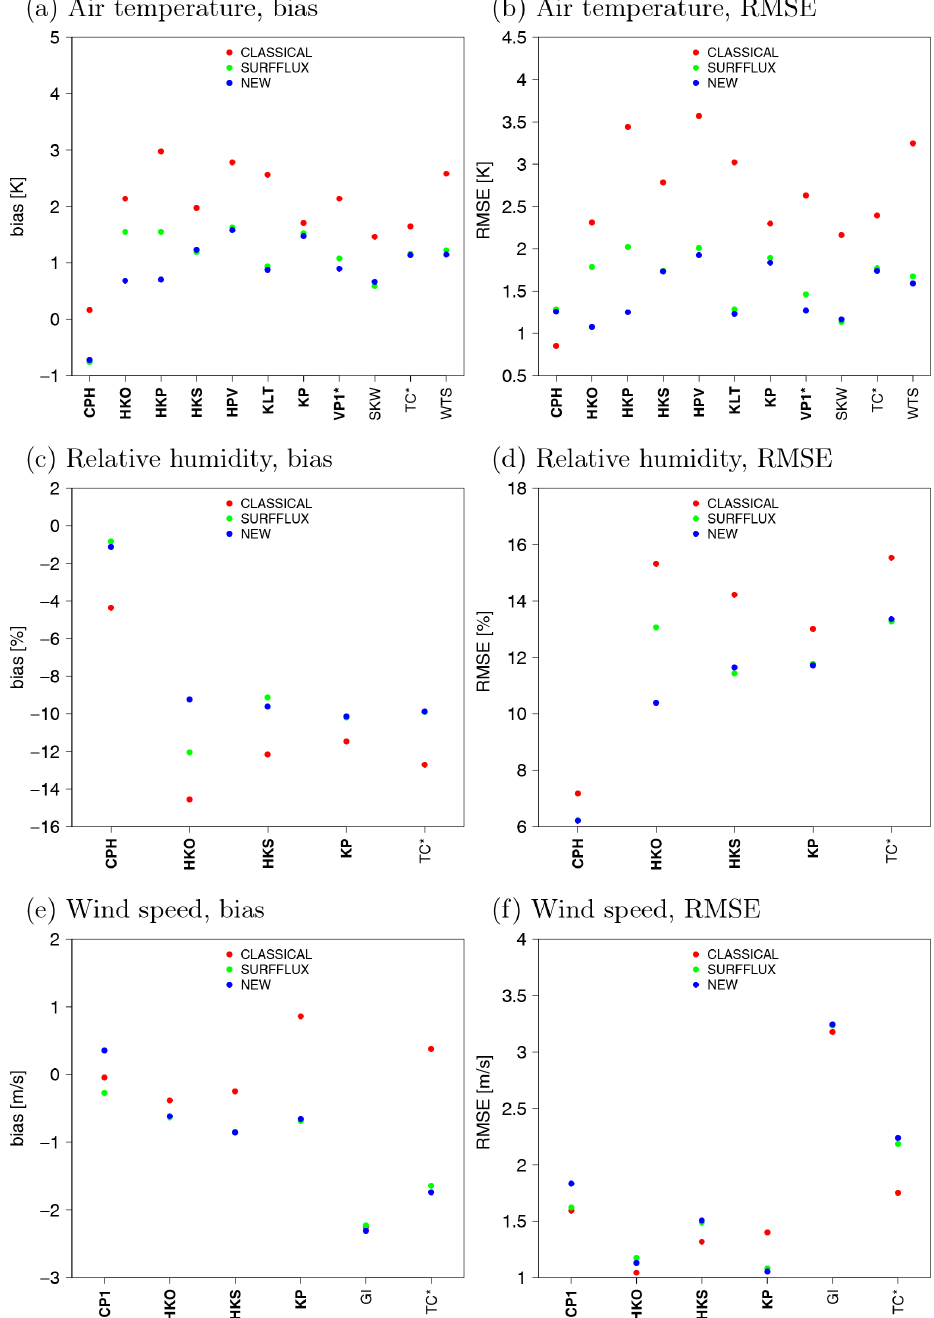
Figure B2. Model evaluation measures for hourly time series at meteorological stations in D5 and for HW2009. The urban stations are bold; the stations on mountain peaks are marked with an asterisk